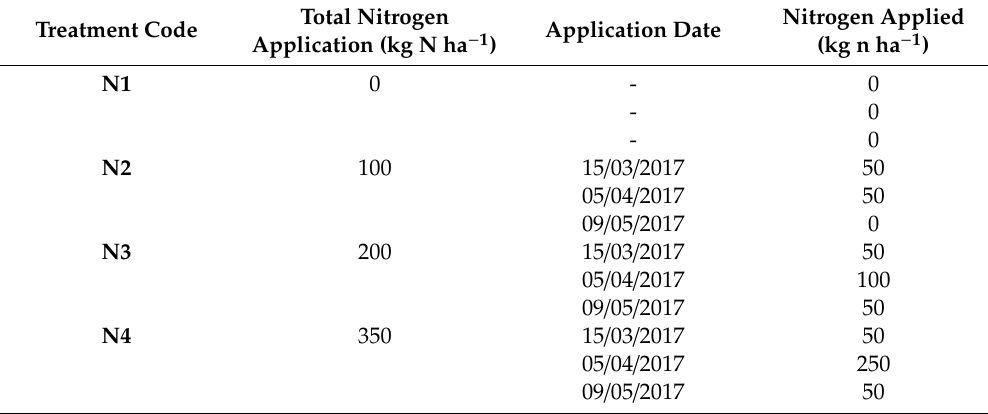
Table 1. Details of the four nitrogen treatments applied to the diversity field experiment for